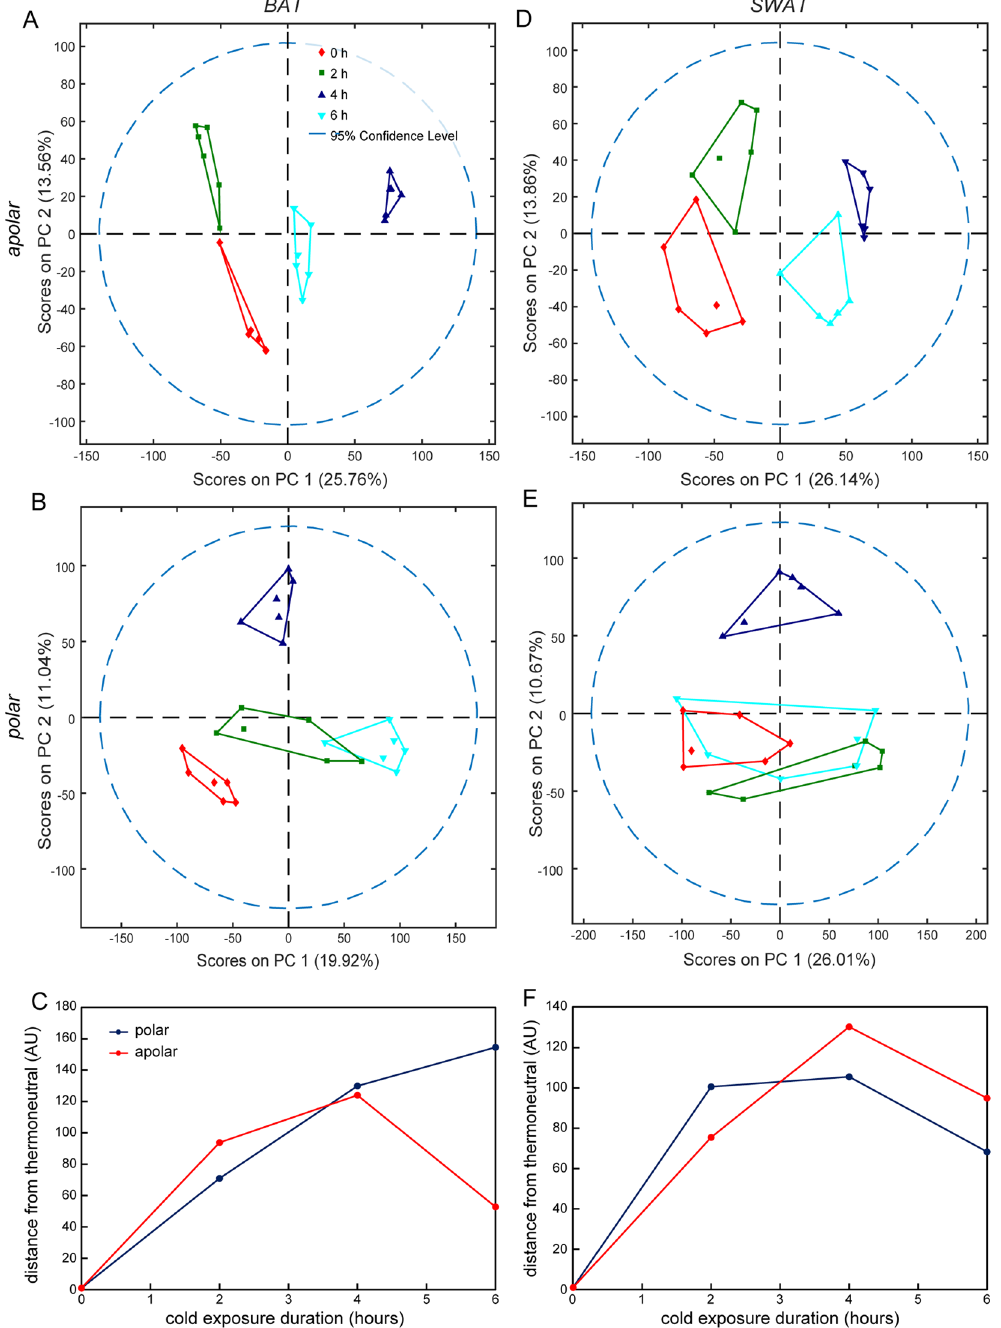
Figure 3. Metabolic changes in adipose tissues from different depots during cold exposure. An untargeted multilevel PCA was performed on combined HPLC-MS and MRS data acquired on BAT and SWAT sample extracts collected at thermoneutrality, and after 2, 4 and 6 hours of cold exposure. Score plots obtained from PCA performed on apolar and polar spectra of BAT ( A , B ) and SWAT ( D , E ) (6 replicates per tissue type) are shown. The average distance of each cold-exposure group from thermoneutrality was calculated for both polar and apolar sample extracts and for both BAT ( C ) and SWAT ( F )